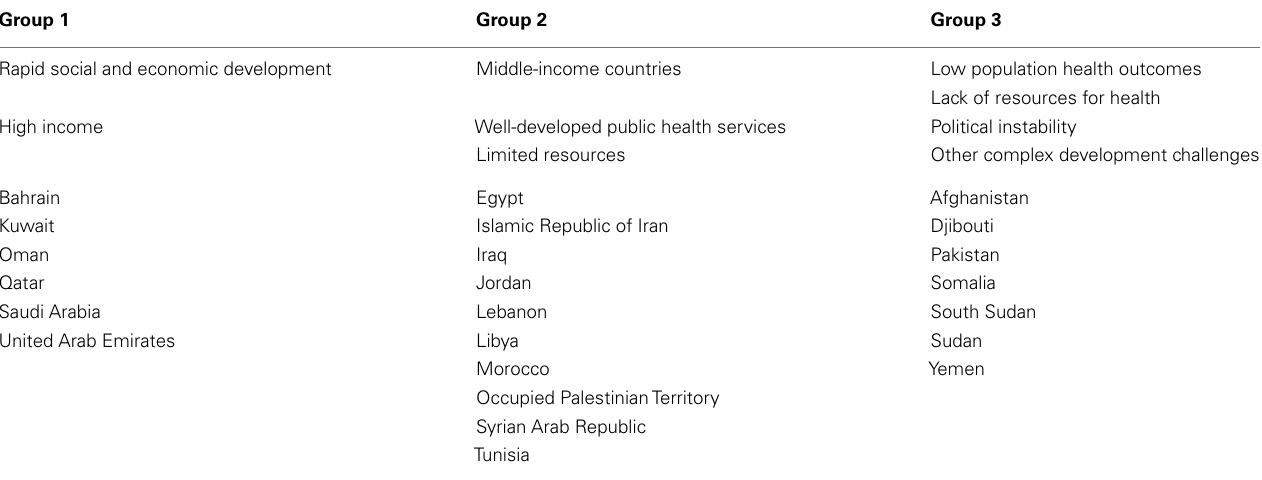
Table 1 |WHO EMR country